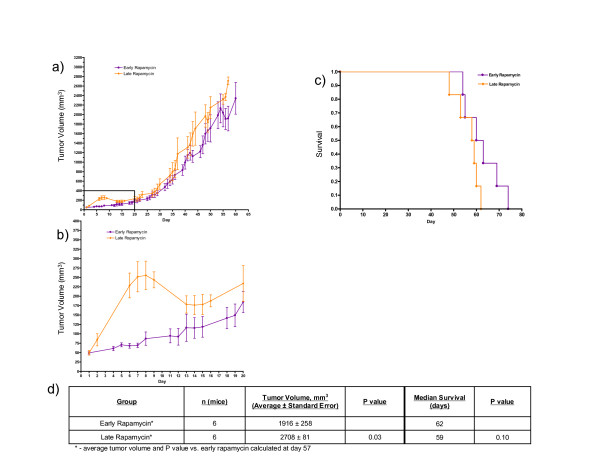
Early rapamycin treatment compared to late rapamycin treatment in nude mice bearing Tsc2-/- tumors. a) Average tumor growth over time for the early rapamycin-treated and late rapamycin-treated cohorts only. b) Enlargement of the boxed portion of part a) illustrating the difference in growth pattern between the two treatment cohorts in the first 20 days of treatment. c) Survival curve for the early rapamycin and late rapamycin-treated cohorts. d) Data shown in table format.